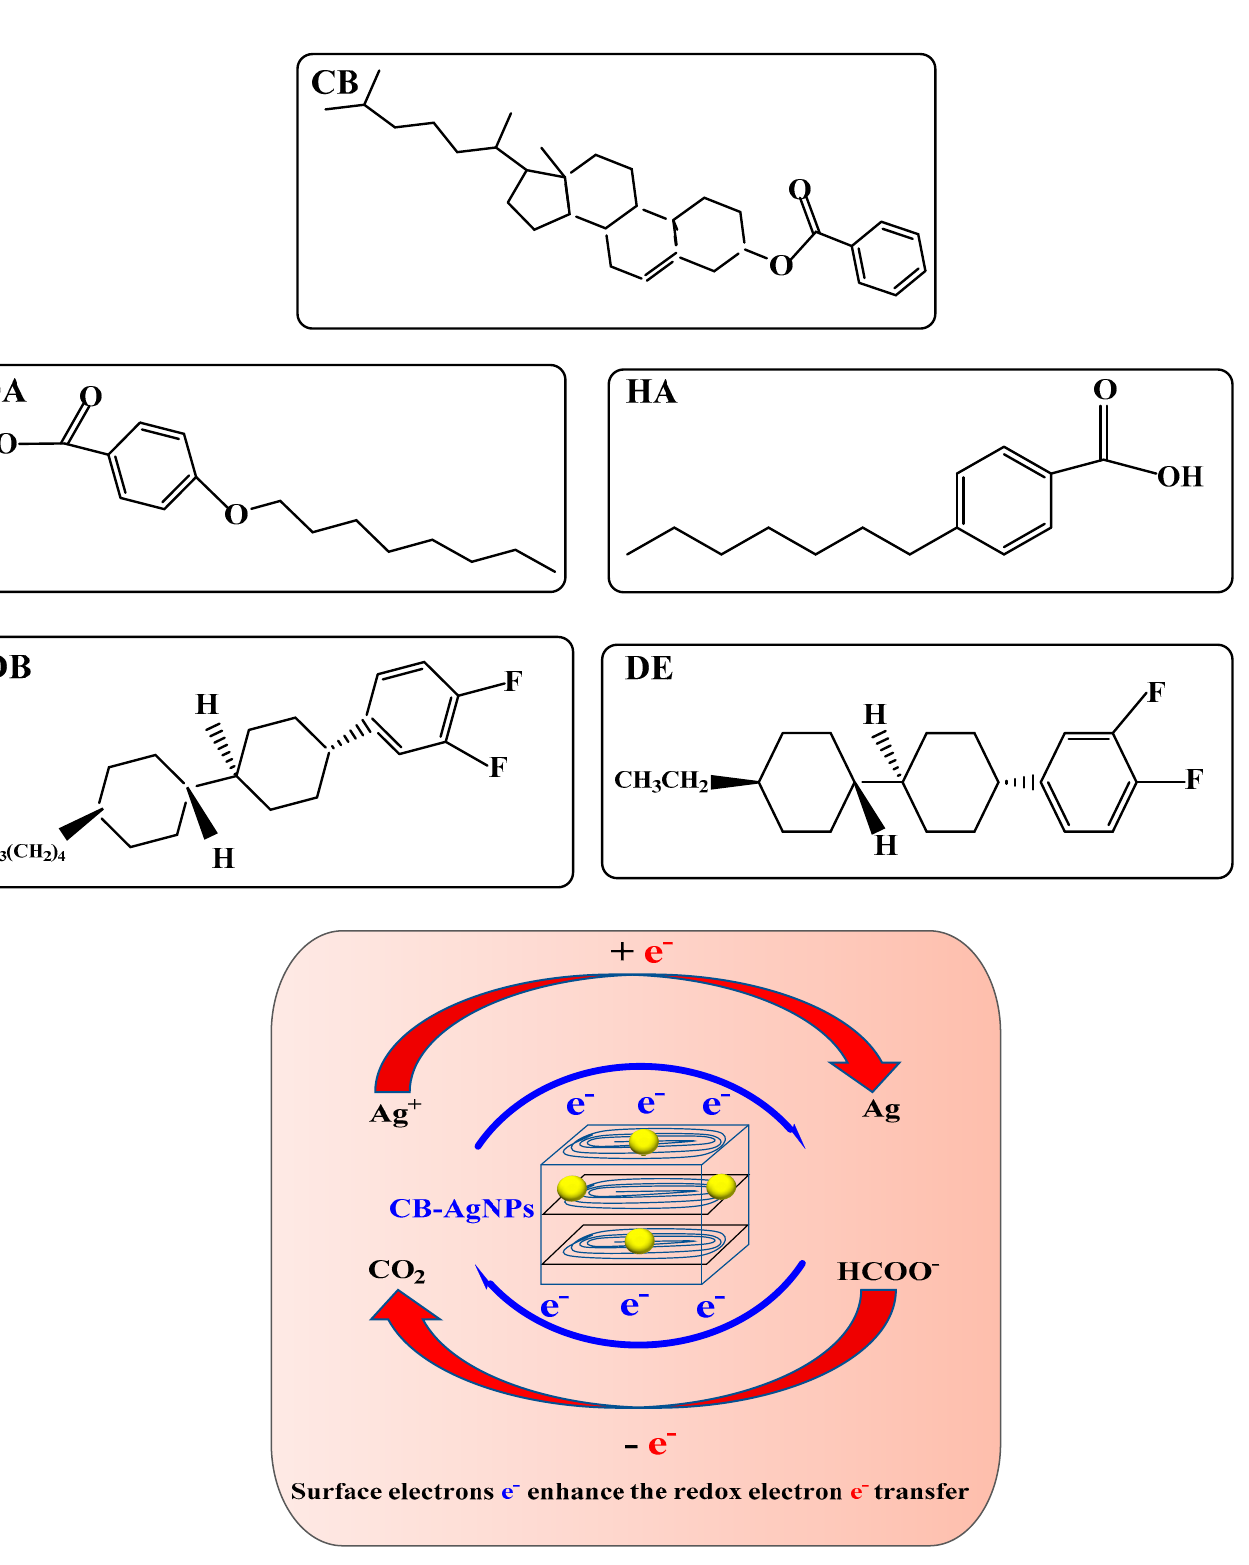
Figure 7. Catalytic enhancement mechanism of LCs and CB@AgNPs on the AgNO 3 -Fo nanoreaction.